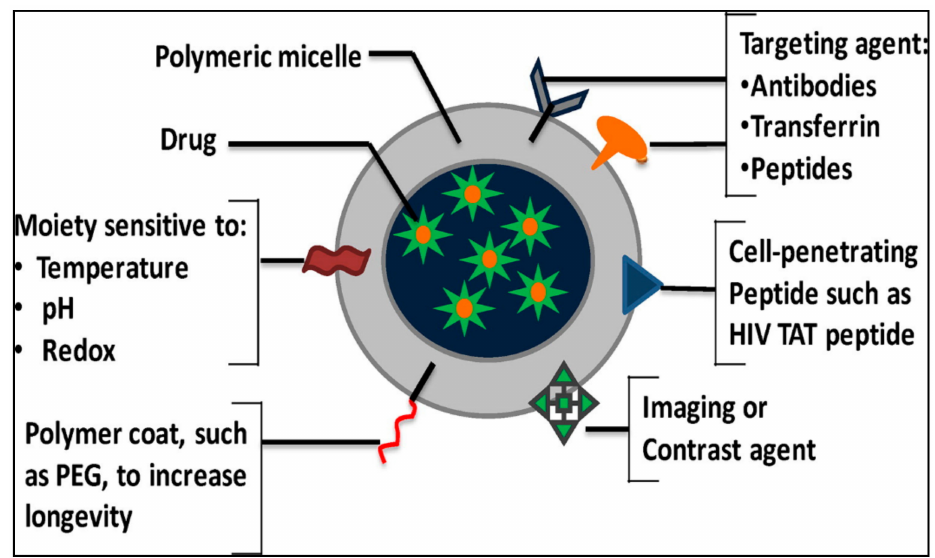
Figure 4. Schematic illustration of the polymeric nanomicelles targeting for drug delivery Reprinted with permission from [105].Copyright © 2016,